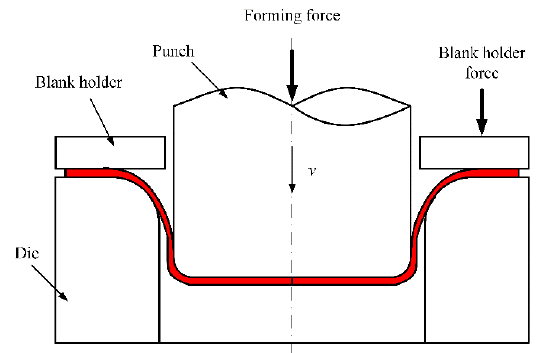
Figure 4. Stamping of tube-shaped part. Table 1. Parameters for drawing processes of tube-shaped parts.